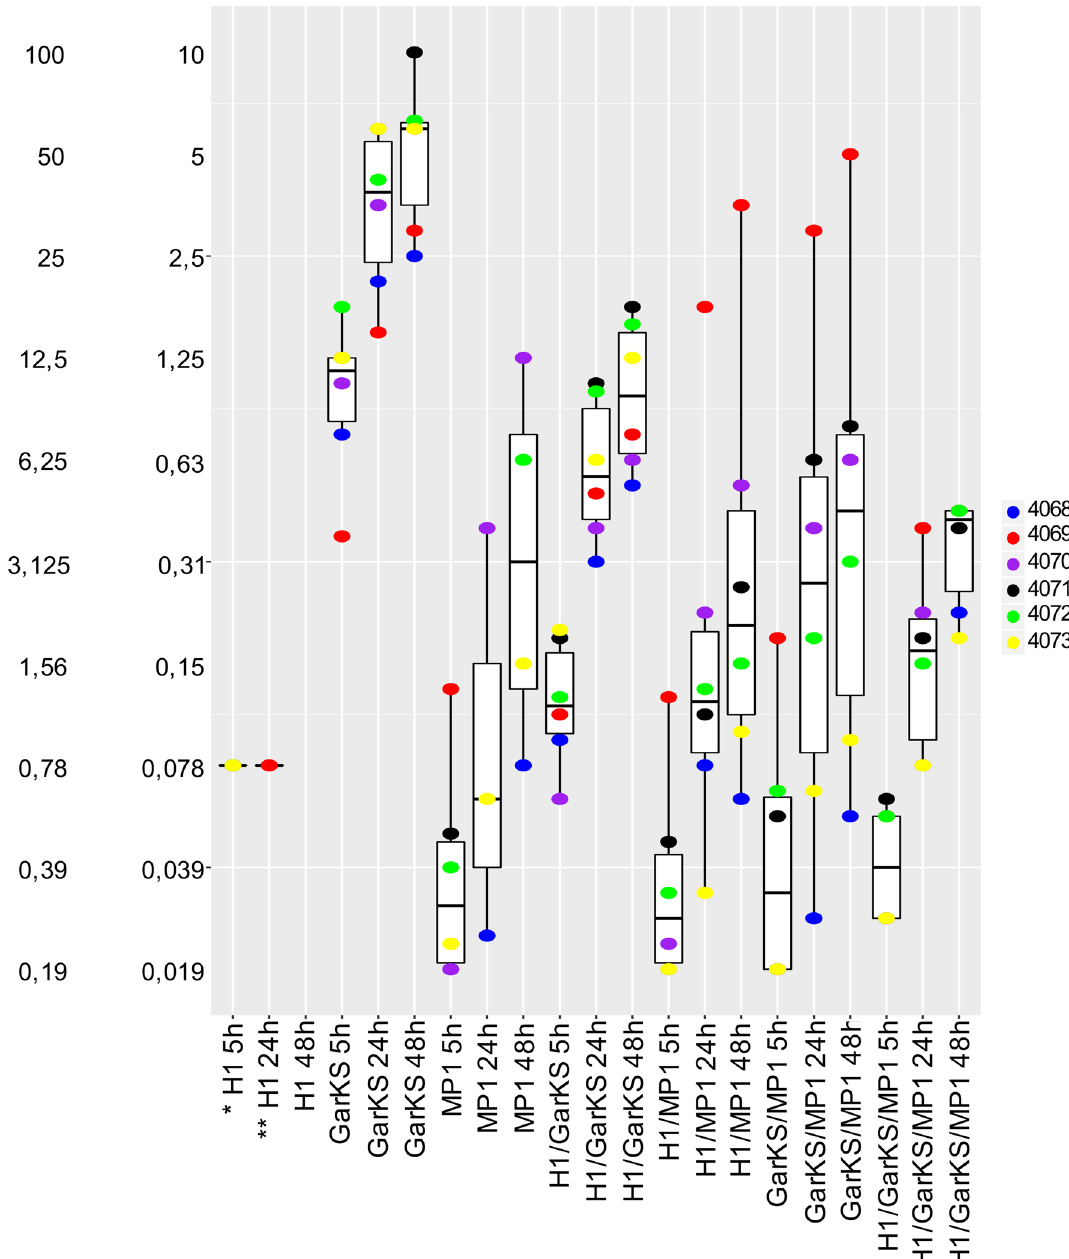
Figure 3. Boxplot of minimal inhibition concentrations (μg/ml) for the treatment with H1, garvicin KS, micrococcin P1 and their combinations against planktonic S. haemolyticus . The median distribution is indicated as thick line within boxes and the degree of variability (amplitude of the box or inter quartile region (IQR)) of the MIC 50 values for the indicated strains obtained at three different time points: 5 h, 24 h and 48 h. Whiskers extending out the boxes mark the minimum and maximum observed values and the variability outside the middle 50% of values (whisker length). Outliers are represented as values that extend out of the whisker limit (1.5×IQR). Note that the treatment with the tricomponent combination (H1/GarKS/MP1) led to contained MIC values and inter-strain variability compared to the other treatments at all time-points. (*)Please note that for the treatment with H1 all strains were sensitive after a 5 h incubation (MIC 50 = 0.78 μg/ml); (**) all strains were resistant after a 24 h incubation, except 4069 (MIC 50 = 0.78 μg/ml); all strains were resistant after a 48 h